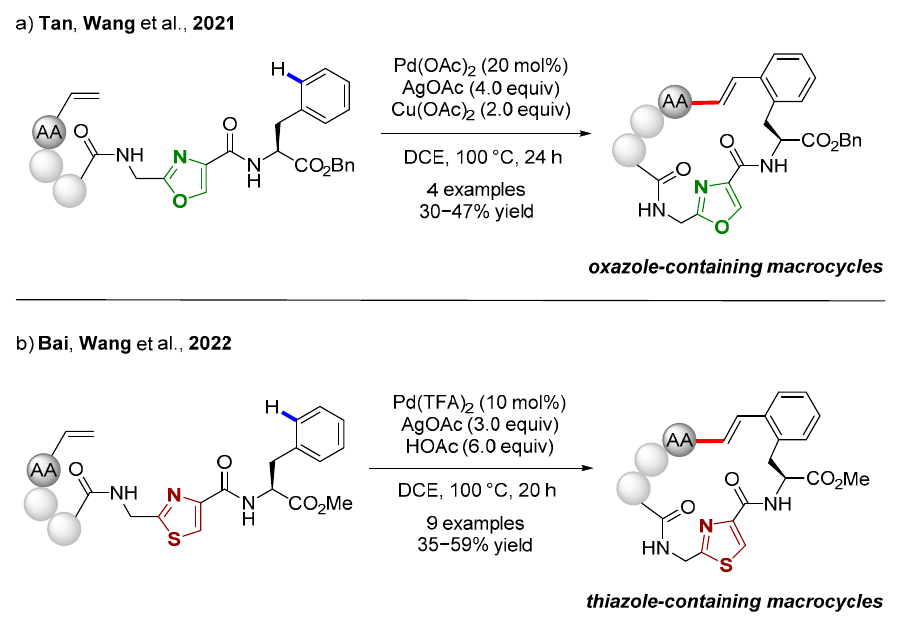
Figure 17. Late ‐ stage macrocyclization via intramolecular δ ‐ C(sp 2 ) − H bond ole fi nation of oxazole ‐ Figure 17. Late-stage macrocyclization via intramolecular δ -C(sp 2 )–H bond olefination of oxazole-and and thiazole ‐ containing peptides [77,78]. thiazole-containing peptides